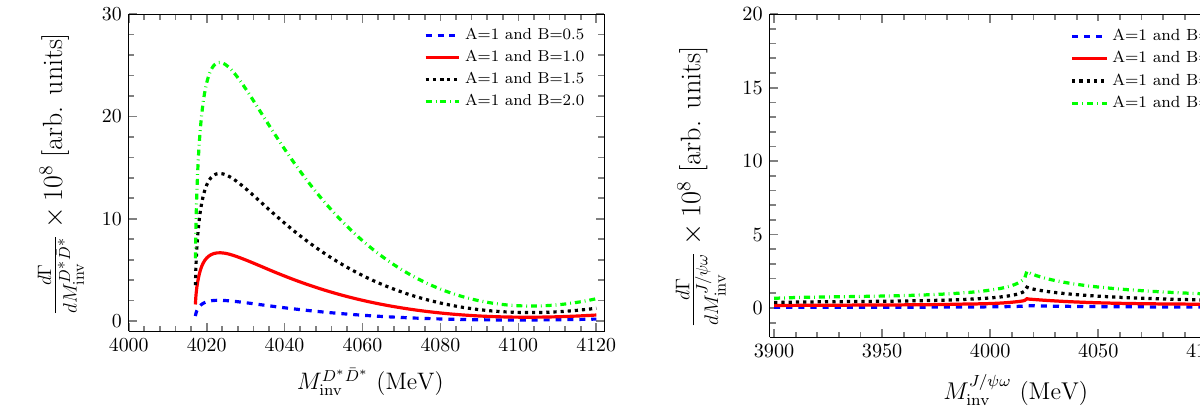
Fig. 7 d (cid:8) results for the different values of the parameter B , dM J /ψω inv